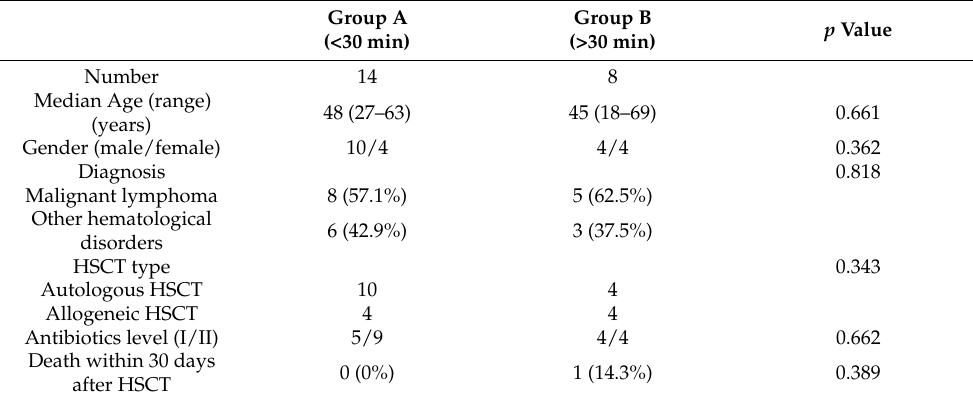
Table 1. Patient characteristics and relevance of antibiotics given time and clinical variables for reducing fever days in